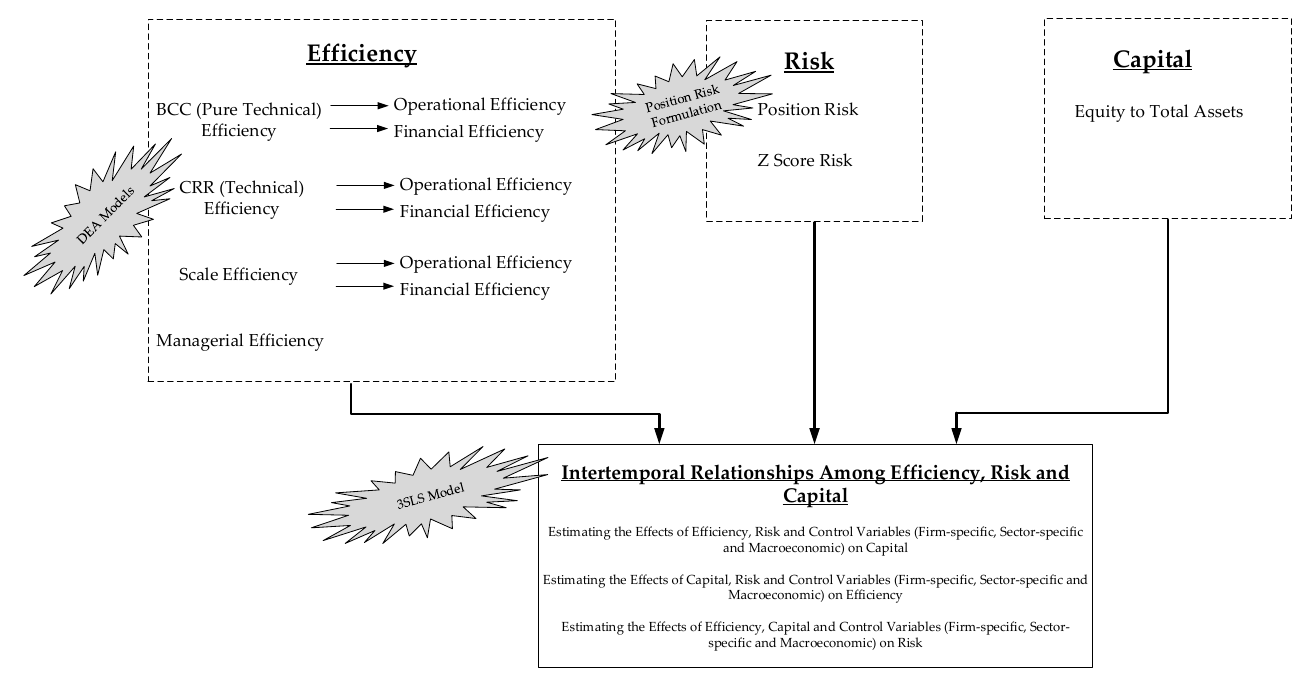
Figure 1. The Methodological Framework. Table 5. Description of variables used in the study.